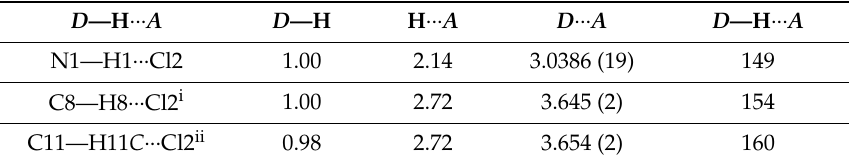
Figure 3. The molecular structure of 1-(4-chlorophenyl)-2-(dimethylamino)propan-1-one hydrochloride ( 1 ), showing the atom-labelling scheme. Table 2. Hydrogen-bond geometry (Å, ◦ ) for Compound 1 .